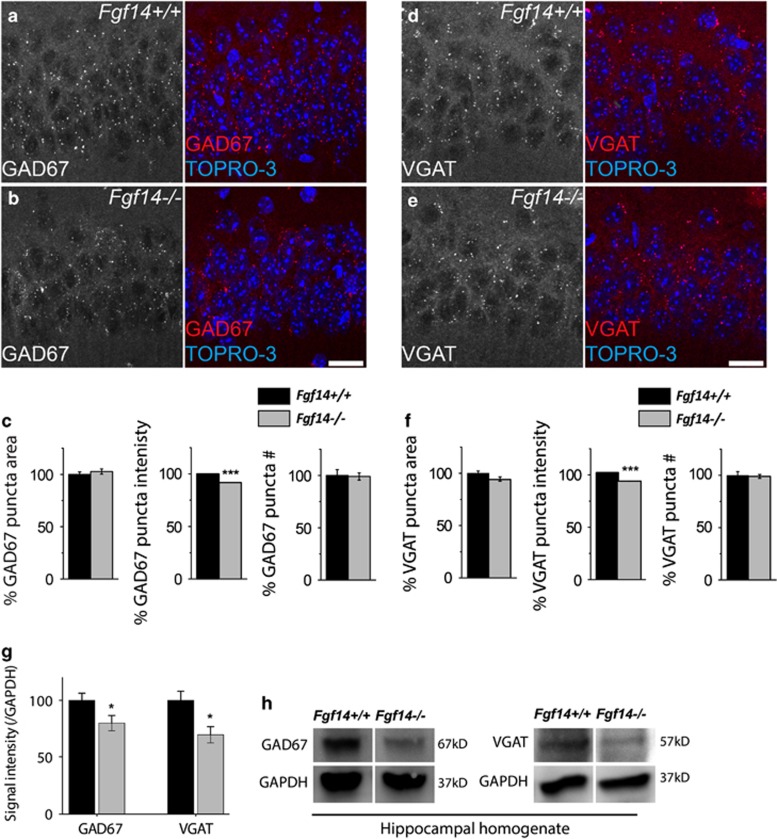
The effect of Fgf14 genetic ablation on GABAergic presynaptic proteins in the hippocampal CA1 region. (a, b) GAD67 representative puncta in CA1 stratum pyramidalis (SP) at high magnification. (c) Quantification of GAD67 puncta area, puncta intensity and puncta number in the indicated genotypes. (d, e) Vesicular GABA transporter (VGAT) representative puncta in CA1 SP at high magnification. (f) Quantification of VGAT puncta area, puncta intensity and puncta number in the indicated genotypes. (g) Quantitative western blot analysis of GAD67 and VGAT from the hippocampus. (h) Immunoblot detection of GAD67 and VGAT in whole hippocampal homogenates from Fgf14−/−mice and Fgf14+/+ controls. Data represent mean±s.e.m., ***P<0.001; **P<0.02; *P<0.05 statistical differences were assessed by Student's t-test or non-parametric Mann–Whitney test. Scale bars, 20 μm (a, d). GABA, gamma-amino-butyric acid; GAD67, glutamic acid decarboxylase 67.